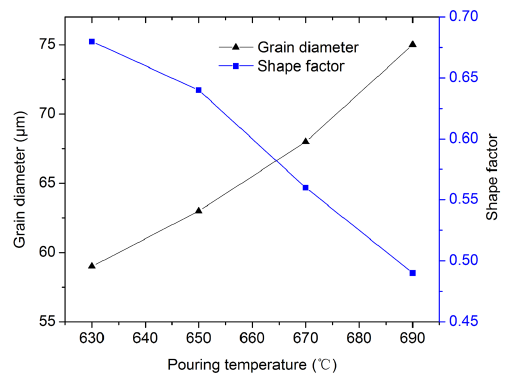
Fig. 5 Effects of pouring temperature on D and S